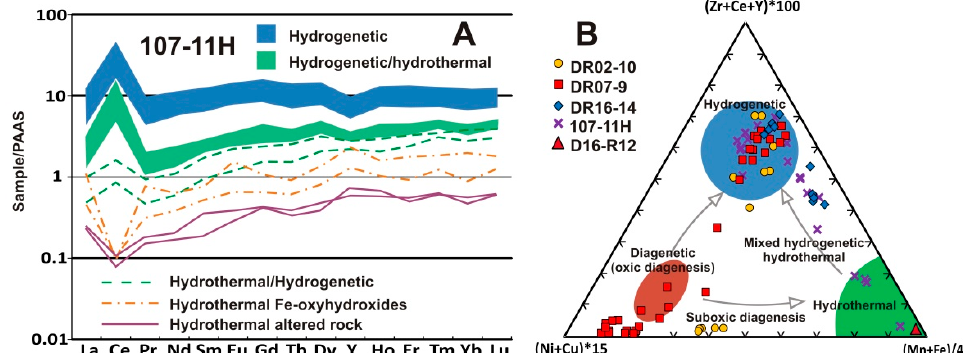
Figure 14. ( A ) REY/PAAS normalized patterns of spot analyses made with LA-ICP-MS on crust 107-11H. In the diagram, it is possible to see the hydrothermal influence in the Fe-Mn oxyhydroxides; ( B ) ternary diagram from [31] in which have been plotted the spot LA-ICP-MS analyses to differentiate the genetic processes that take place in CISP Fe-Mn crusts and the plot of one sample of Fe-oxyhydroxides obtained from the the eruption of the Tagoro volcano on El Hierro Island.